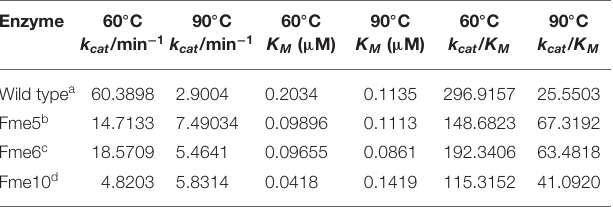
TABLE 3 | Kinetic parameters of Fm-PEP variants determined using a synthetic substrate, Z-Gly-Pro-pNA. Enzyme 60 ◦